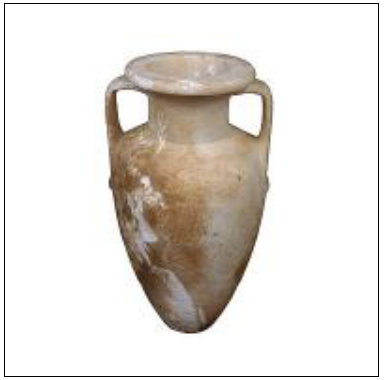
Figure 2: Alabaster vessel from the third dynasty (the step pyramid) in the Egyptian museum- Egypt